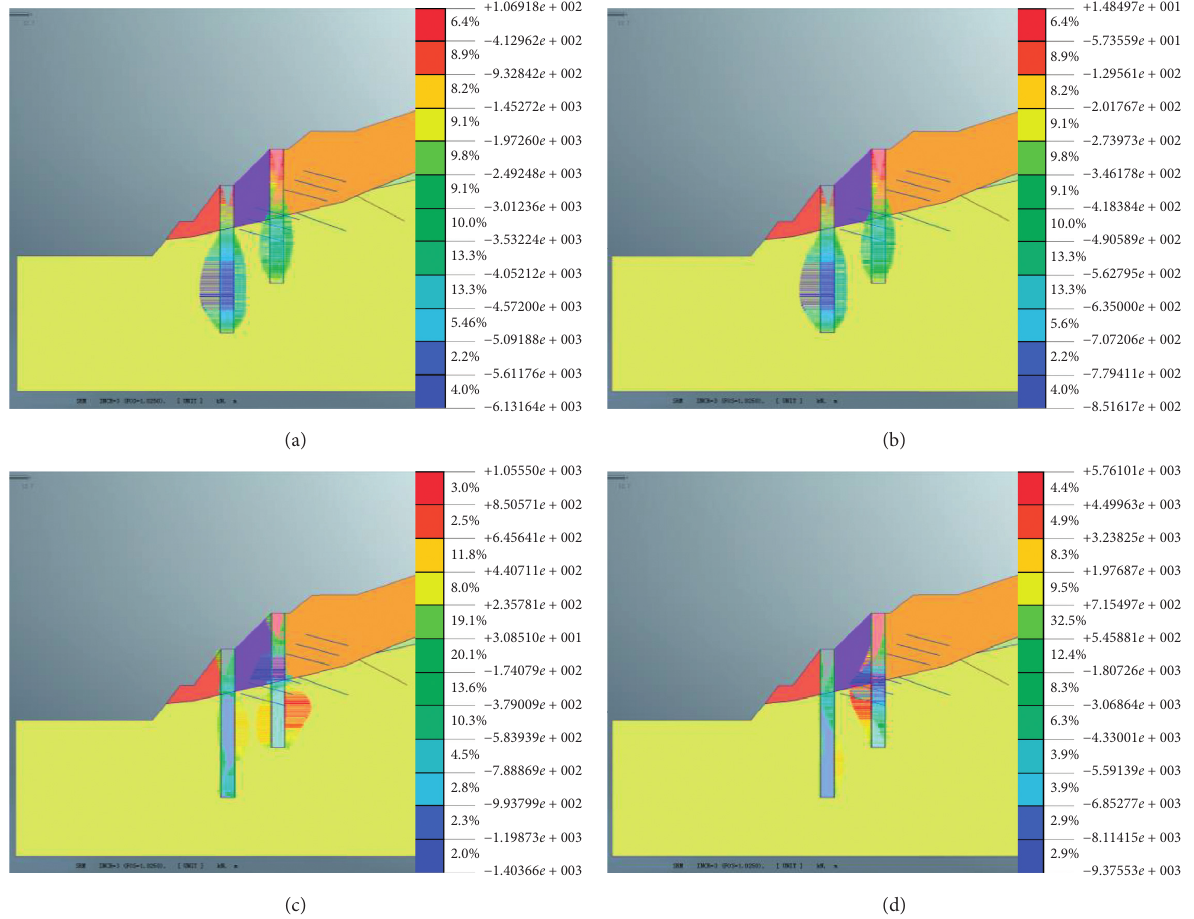
Figure 15: Cloud diagrams of the antislide piles when considering steady-state seepage: (a) axial force; (b) axial stress; (c) shear force; (d) bending